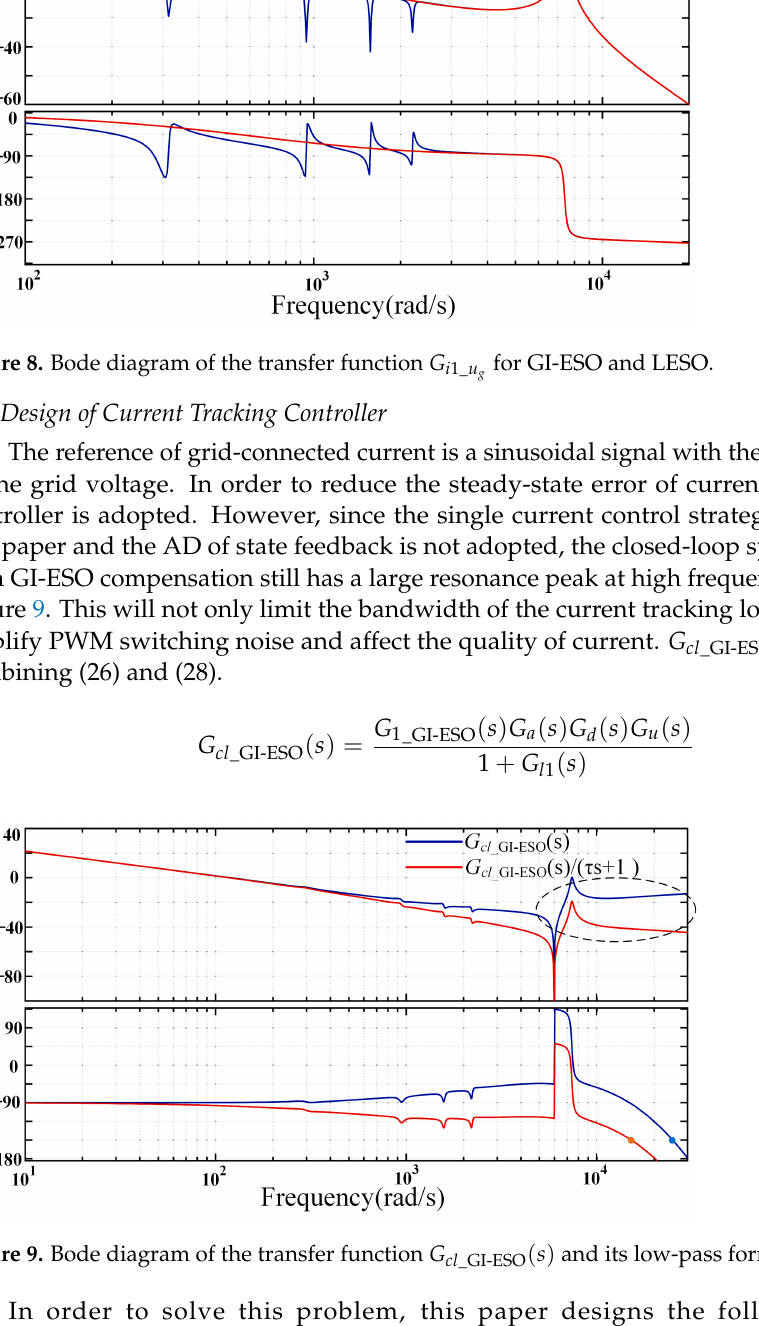
Figure 8. Bode diagram of the transfer function G i 1_ u